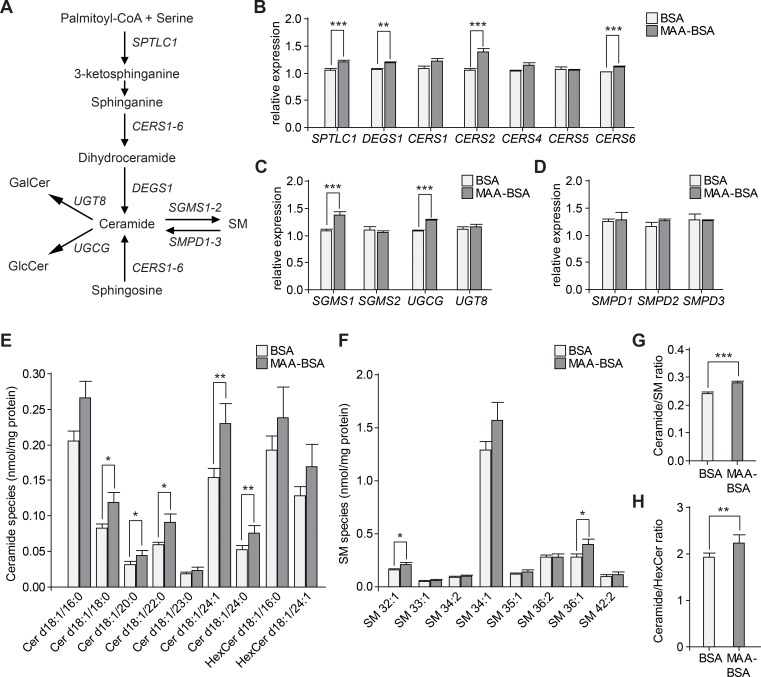
Alteration of the sphingolipid metabolism under MAA-BSA treatment in WERI-Rb1 cells.(A) The sphingolipid pathway depicting the gene symbols of the enzymes involved (complete protein names in S2 Table). (B-H) Cells were treated with 80 μg/mL of BSA or MAA-BSA for 24 h, and gene expression or lipid levels were measured. (B) Genes from the de novo and salvage ceramide synthesis pathways. (C) Genes involved in the synthesis of SM from ceramides, and synthesis of glucosylceramides (GlcCer) and galactosylceramides (GalCer), both hexosylceramides (HexCer). (D) Genes involved in the generation of ceramide by sphingomyelin (SM) hydrolysis. (E) Ceramide (Cer) species levels. (F) SM species levels; only results from most abundant species are shown. (G) Ratio of total ceramide to total SM levels. (H) Ratio of total ceramide to total HexCer levels. Each value corresponds to the mean ± SEM of six-fold independently performed replicates evaluated in two batches. Statistics: Linear regression adjusted for batch of analysis; ***p<0.001, **p<0.01, *p<0.05.